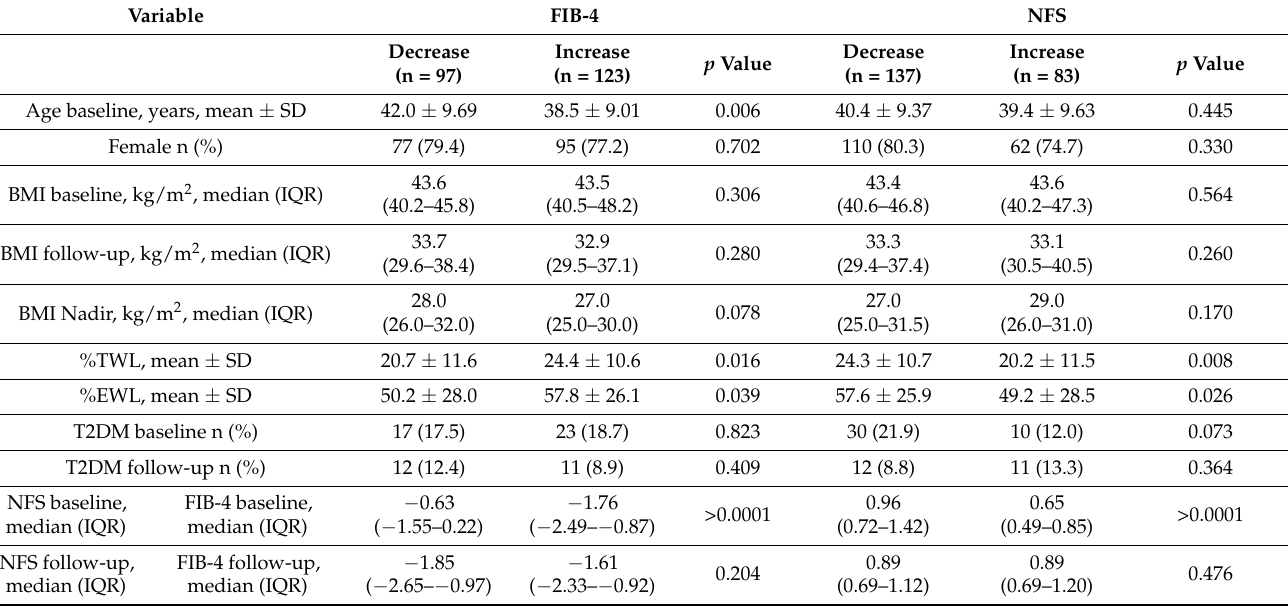
Table A1. Patients with reduction of fibrosis scores vs. patients with increased scores 11.6 years after Roux-en-Y gastric bypass